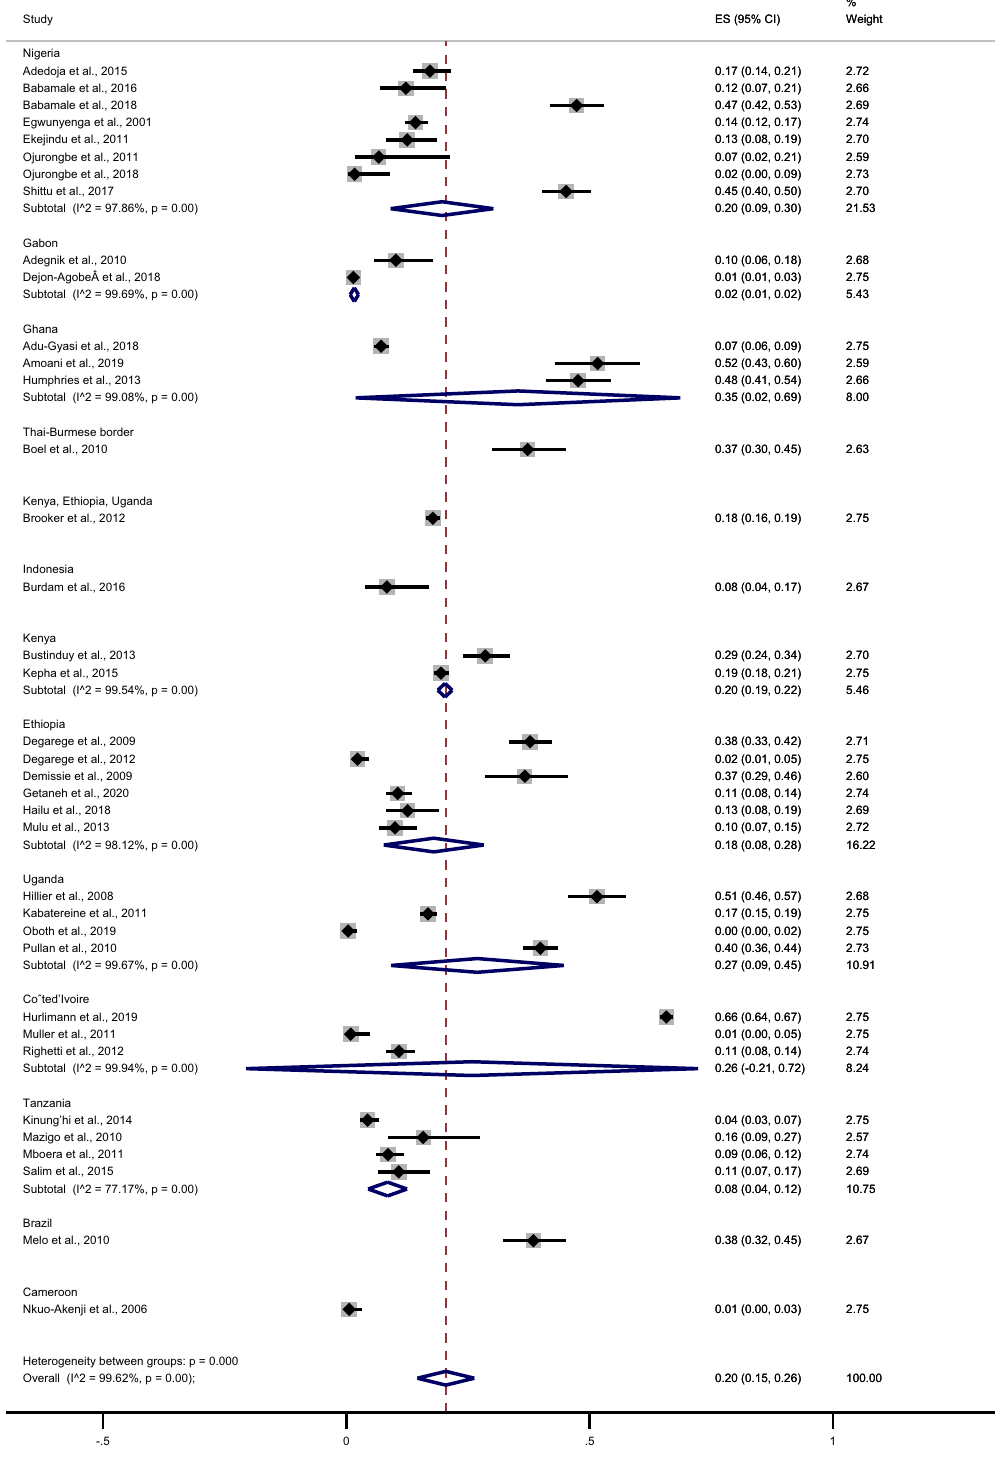
Figure 3. Pooled prevalence of Plasmodium spp. and hookworm co-infection stratified by countries. ES prevalence estimates (× 100), CI confidence